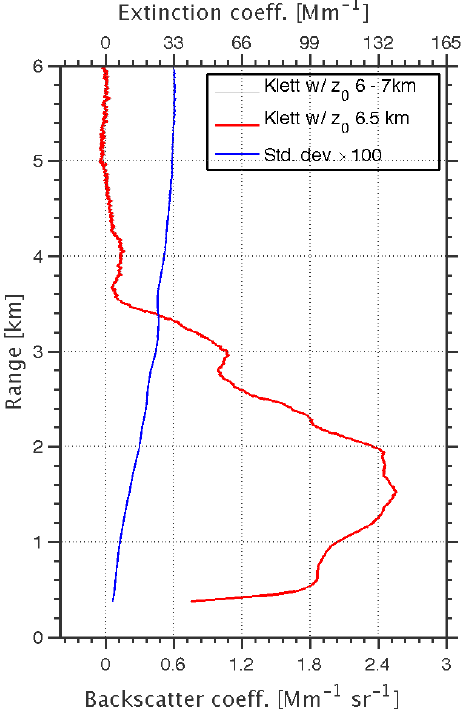
Figure 8. Backscatter coefficient obtained with the Klett algo- Figure 7. Estimation of the error in the extinction coefficient from rithm with reference height z 0 varying from 6 to 7km in steps of 39 the uncertainty in the overlap function are shown in thick lines. For 50m (gray) and the default inversion with z 0 = 6 . 5km (red) are Fig. 7. Estimation of the error in the extinction coefficient from the uncertainty in the overlap function reference, the mean overlap functions and the 95% confidence level shown. The standard deviation (blue) is multiplied by 100. Data are to the right. Red (blue) colors are used for the wide (narrow) the are shown in thick lines. For reference, the mean overlap functions and the 95 % confidence level are to from 1 September 06:30p.m. to 2 September 05:00a.m. was used. field stops. the right. Red (blue) colors are used for the wide (narrow) the field stops. The extinction scale on top was scaled with L p 38